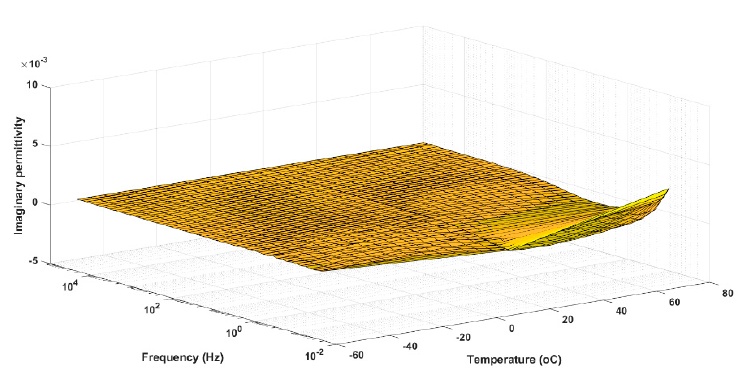
Figure 9. Dielectric losses of low-density polyethylene (LDPE) as functions of temperature and frequency.